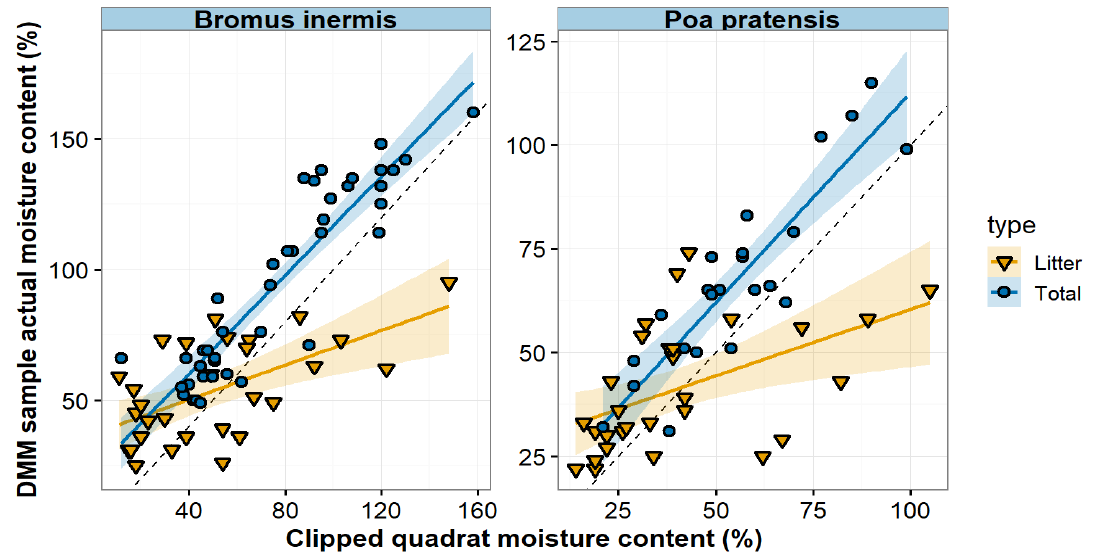
Figure 1. Actual (oven-dried) moisture content of grass fuel samples collected for the Campbell Scientific Duff Moisture Meter (DMM600) plotted against actual moisture content of clipped quadrats meant to represent fine-fuels, generally, for two exotic cool-season grasses in the Northern Great Plains. Overall model R 2 = 0.70, χ 2 = 142, p < 0.001. Both factor terms were statistically different: fuel type ( χ 2 = 38, p < 0.001) and species ( χ 2 = 8.8, p < 0.01). Dotted lines plot the 1:1 relationship at which variables would be perfectly correlated. Data are divided into total fuelbed and litter